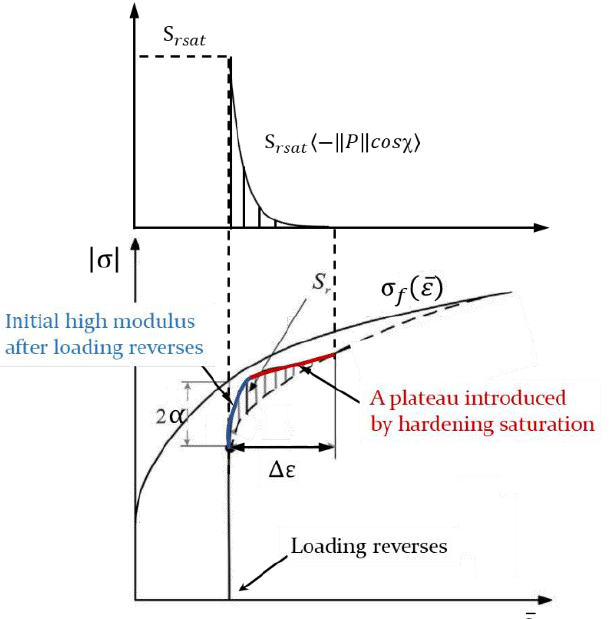
Figure 9. Schematic of the YU 02 model’s description of reverse hardening saturation: ( a ) the yield surface and ( b ) the stress – strain curve. Reprinted with permission from Ref. [61]. 2002, Yoshida, F. et al.